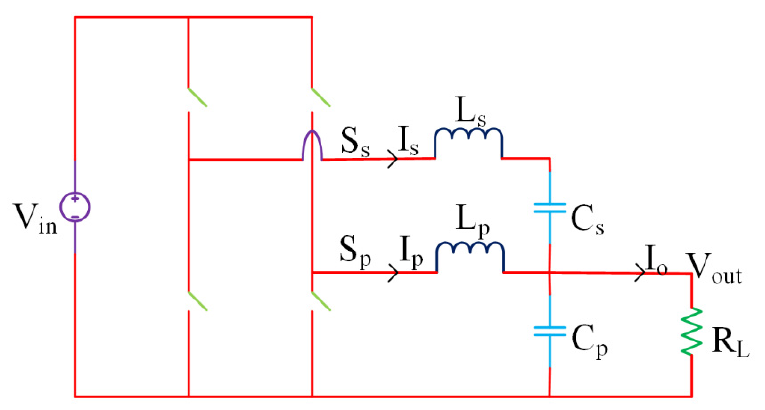
Figure 9. Stacked interleaved topology [44]. Reproduced from [44], IEEE Journal of Solid State Circuits: 2008.